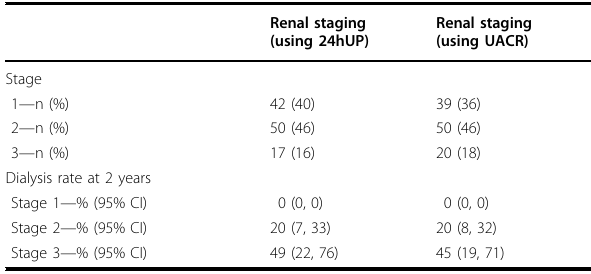
Table 5 Renal staging system at time of urine collection (total n = 109).